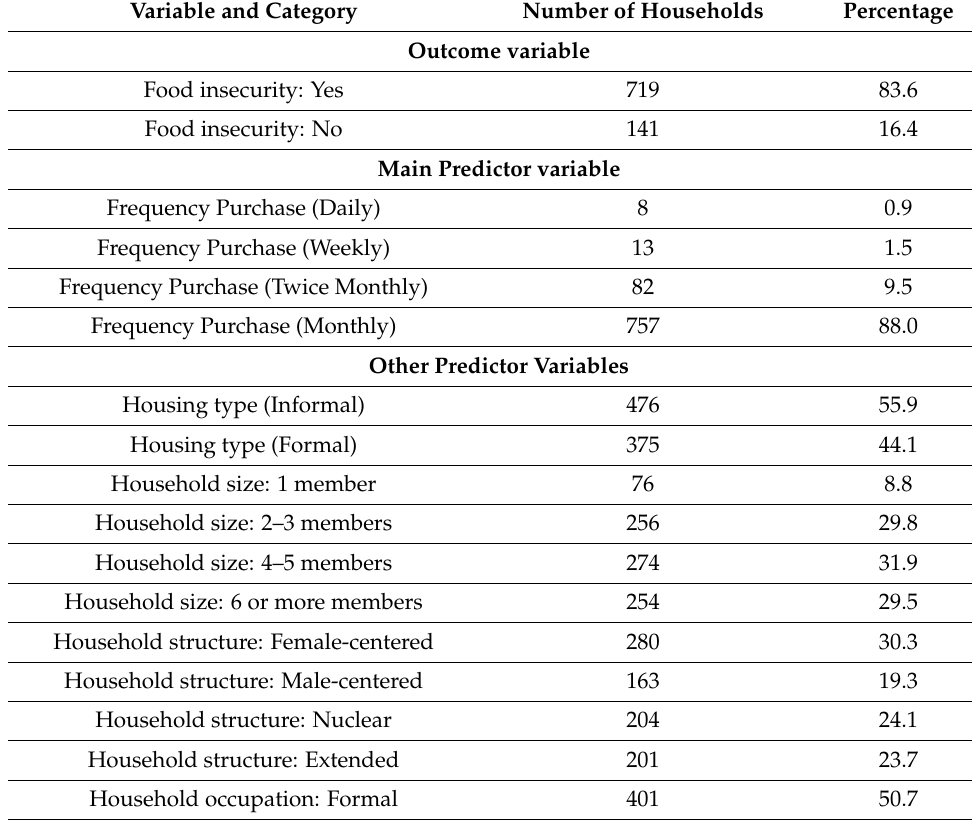
Table 1. Frequency distribution of variables used in the analysis. Variable and Category Number of